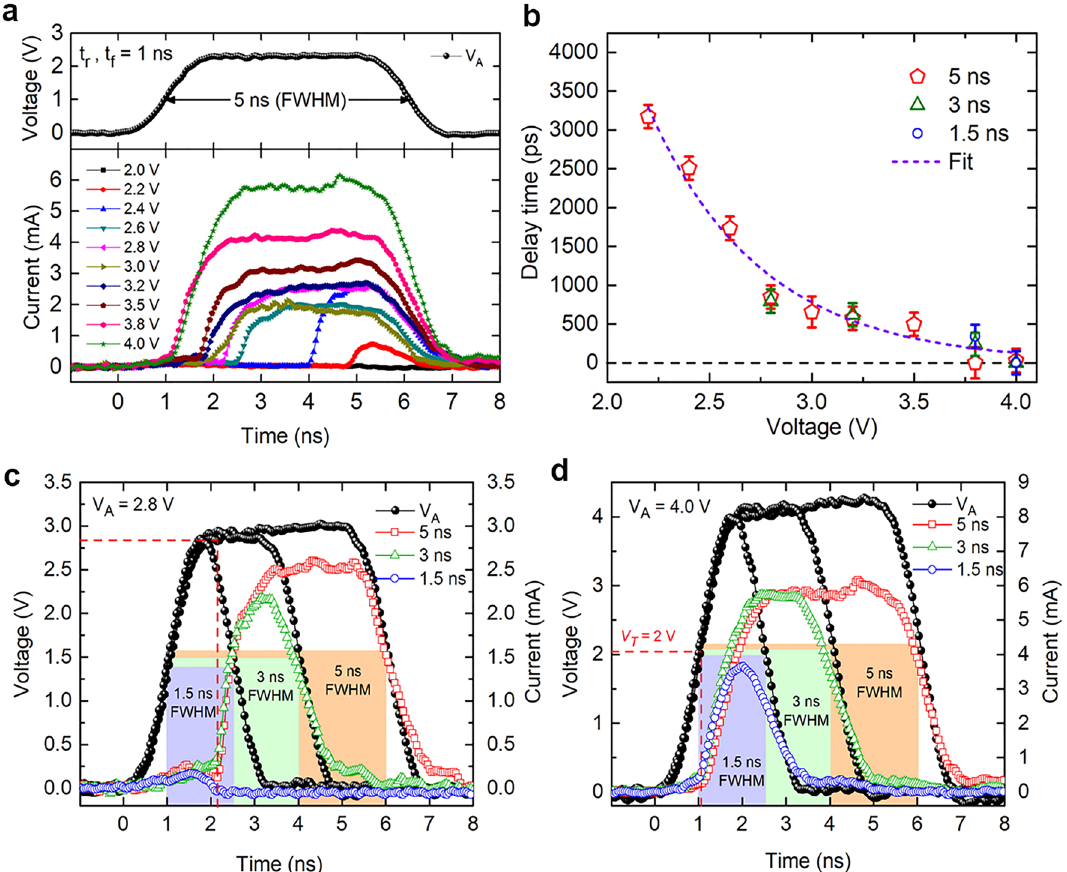
Figure 2. Voltage-dependent delay time characteristics for short (< 5 ns) voltage pulses. ( a ) Time-resolved measurement of I d for voltage pulses with varying amplitudes (2.0–4.0 V) and a constant pulse pattern of 1 ns rise, fall time and 5 ns pulse-width. ( b ) Voltage-dependent delay time characteristics for various voltage pulses having pulse-width of 5 ns (red pentagon), 3 ns (green triangle) and 1.5 ns (blue circle). ( c ) Black spheres form voltage pulses of 2.8 V (or 4.0 V in d ) with rectangular boxes indicating their pulse-width with red (5 ns), green (3 ns) and blue (1.5 ns) color respectively (Heights of boxes are kept different for better visibility only). Device currents corresponding to these voltage pulses show that amplitude of 2.8 V is sufficient to switch the device with pulse-width of 5 ns and 3 ns but not with 1.5 ns. ( d ) Switching event moves from plateau region to leading edge of applied voltage pulse with sufficient over-voltage. I d for all three pulses show that with amplitude of 4.0 V, the device switches almost instantaneously after experiencing V T without any measurable